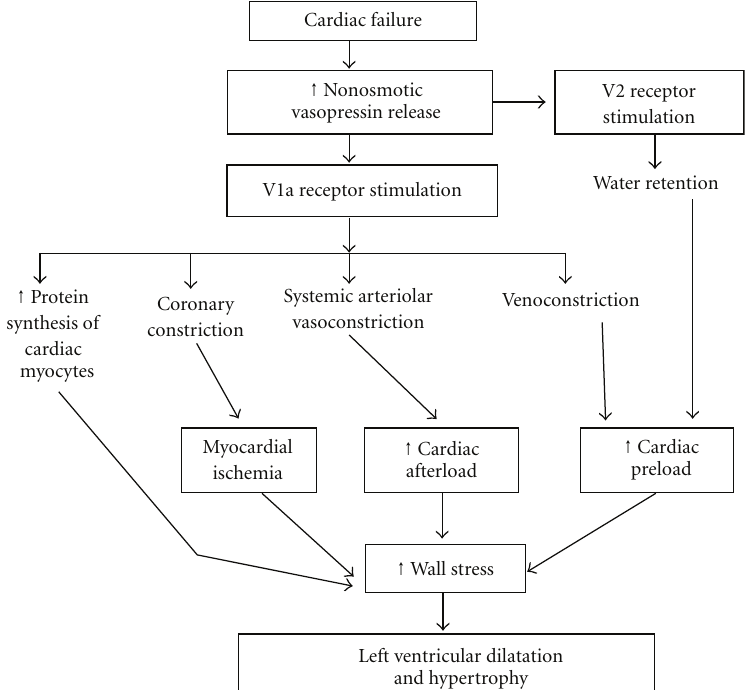
Figure 3: Vasopressin stimulation of V2 and V1a receptors can contribute to events that worsen cardiac function (with permission from